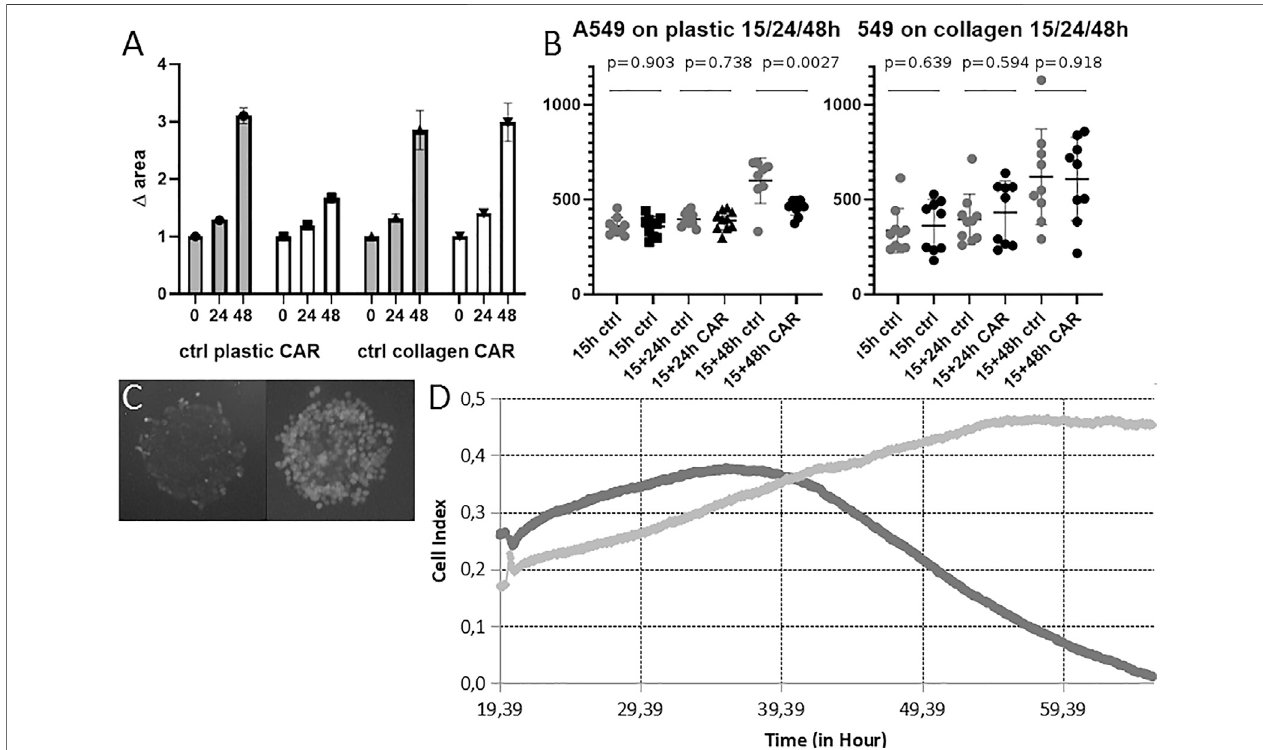
FIGURE8|CellmigrationfromMCTSonplasticandcollageninpresenceofcarboplatin.(A) Changesintheareainhabitedbycellsafterincubationwith100 μ M carboplatinfor24and48 honplasticandcollagen.Carboplatinwasadded15 hafterMTCSseeding.Dataobtainedfromthreetechnicalrepeatswith10wellsforeachcondition and presented asthe mean ± SD (B) Changes in diameter of MTCSincubated in presenceof100 μ M carboplatin for 24 and 48 h on plastic and collagen. Data obtained from three technical repeats and presented as the mean ± SD. Cell viability after incubation with 100uM carboplatin for 24 h followed by 48 h washout on plastic. (C) MTCS incubated on plastic in presence of 100 μ M carboplatin for 48 h (left) and in control (right) . Staining with Fluorescein vital dye reveals live cells. (D) RTCA measurements of growth kinetics of the area inhabited by the cells migrating from single MCTS incubated with carboplatin on plastic. Representative image of growth kinetics for control MCTS (light gray) and MCTS incubated with 100 μ M carboplatin added at 20 h for 48 h (dark gray) normalized by empty well. Representative data from two repeats in six runs.